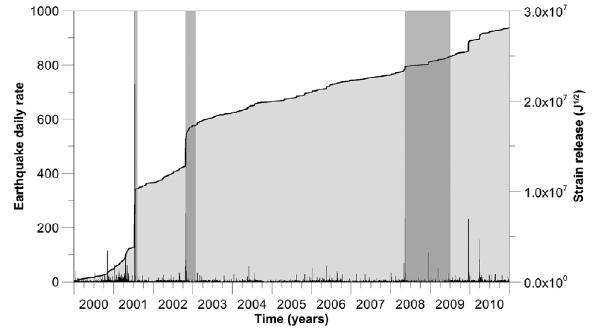
Figure 5. Daily earthquake occurrence and related cumulated strain release from 2000 to 2010. The periods marked in dark gray indicate the main flank eruptions.